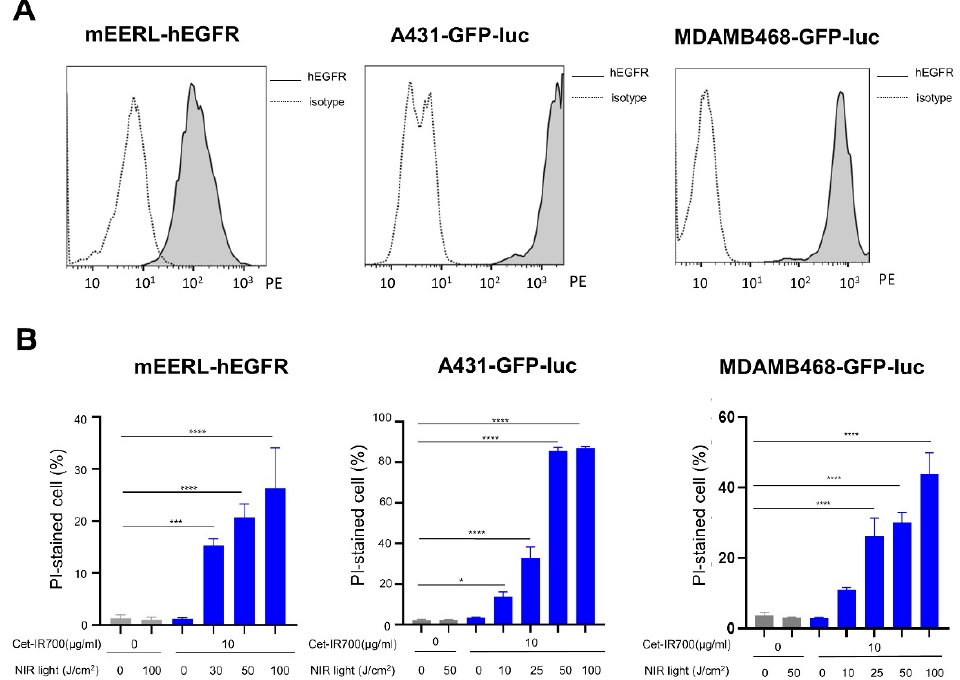
Figure 1. Efficacy of the NIR-PIT with Cet-IR700 in vitro: ( A ) In vitro hEGFR expression on mEERL- hEGFR, A431-GFP-luc, and MDAMB468-GFP-luc cells by flow cytometric analysis; ( B ) cell death induced by NIR-PIT with Cet-IR700 analyzed by flow cytometry using propidium iodide (PI) staining ( n = 4; one-way ANOVA followed by Tukey’s test; *, p < 0.05; ***, p < 0.001; ****, p <